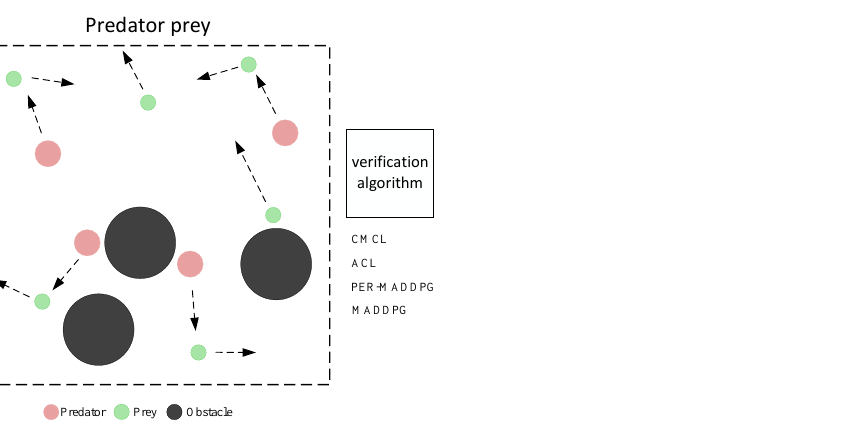
Figure 11. Schematic diagram of adversarial environment.